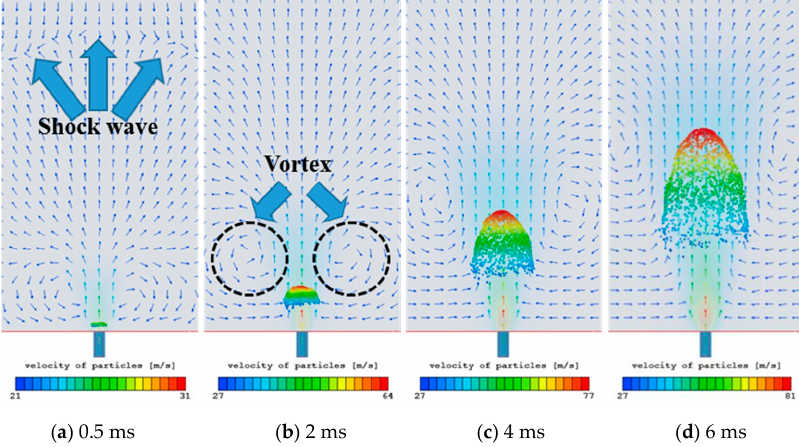
Figure 10. The simulated dispersion process of the quartz sand particles with an average diameter of 0.95 mm. ( a ) at 0.5 ms; ( b ) at 2 ms; ( c ) at 4 ms; ( d ) at 6 ms.